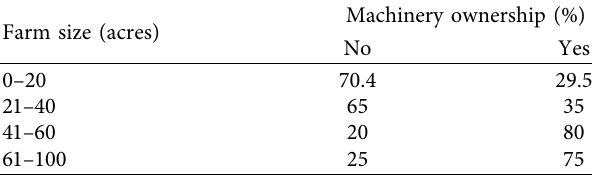
Table 1: Farm size and agricultural machinery ownership.